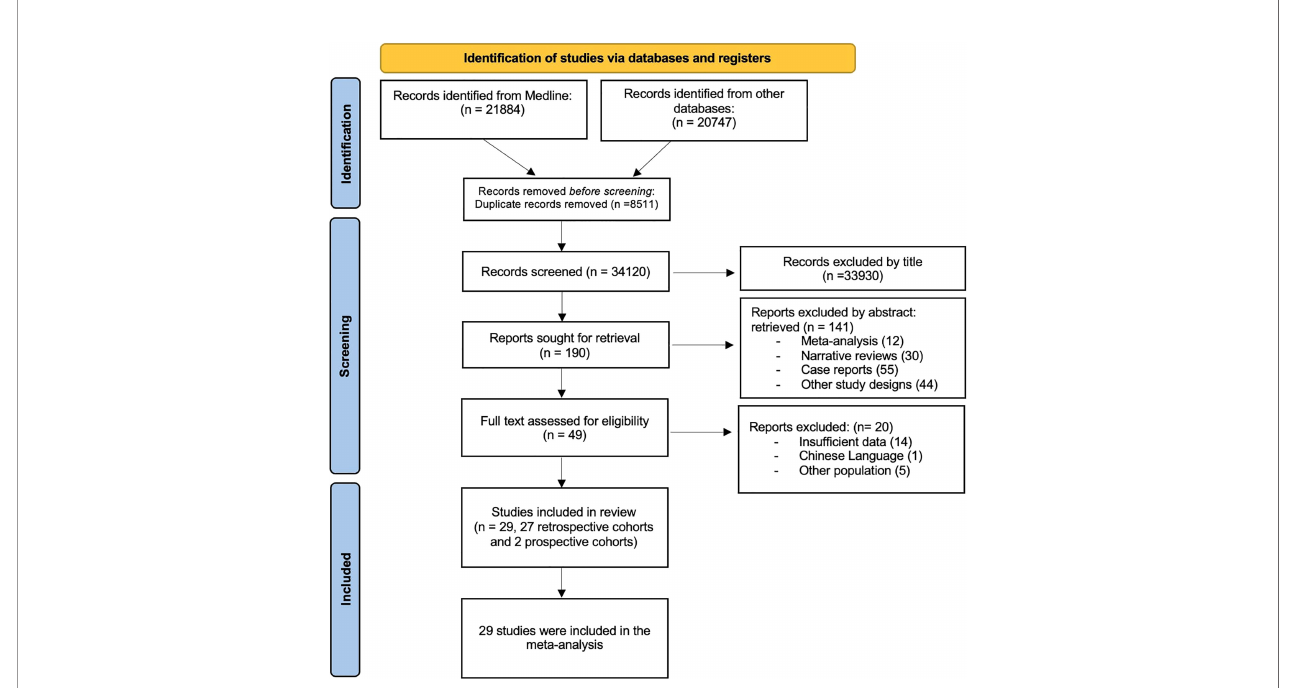
FIGURE 1 | PRISMA fl ow